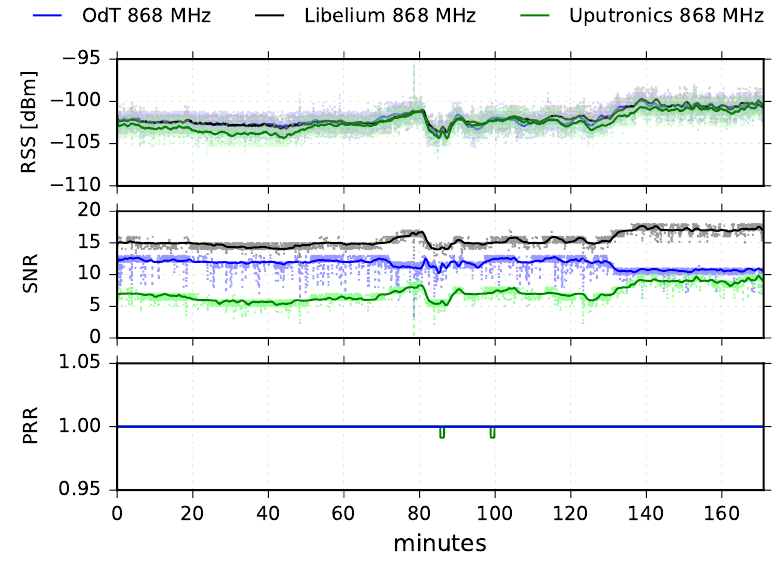
Figure 11. RSS, SNR, and PRR for ODT, Libelium, and Uputronics at 868MHz in LOS channel conditions for BW = 125kHz, SF = 10, and CR =